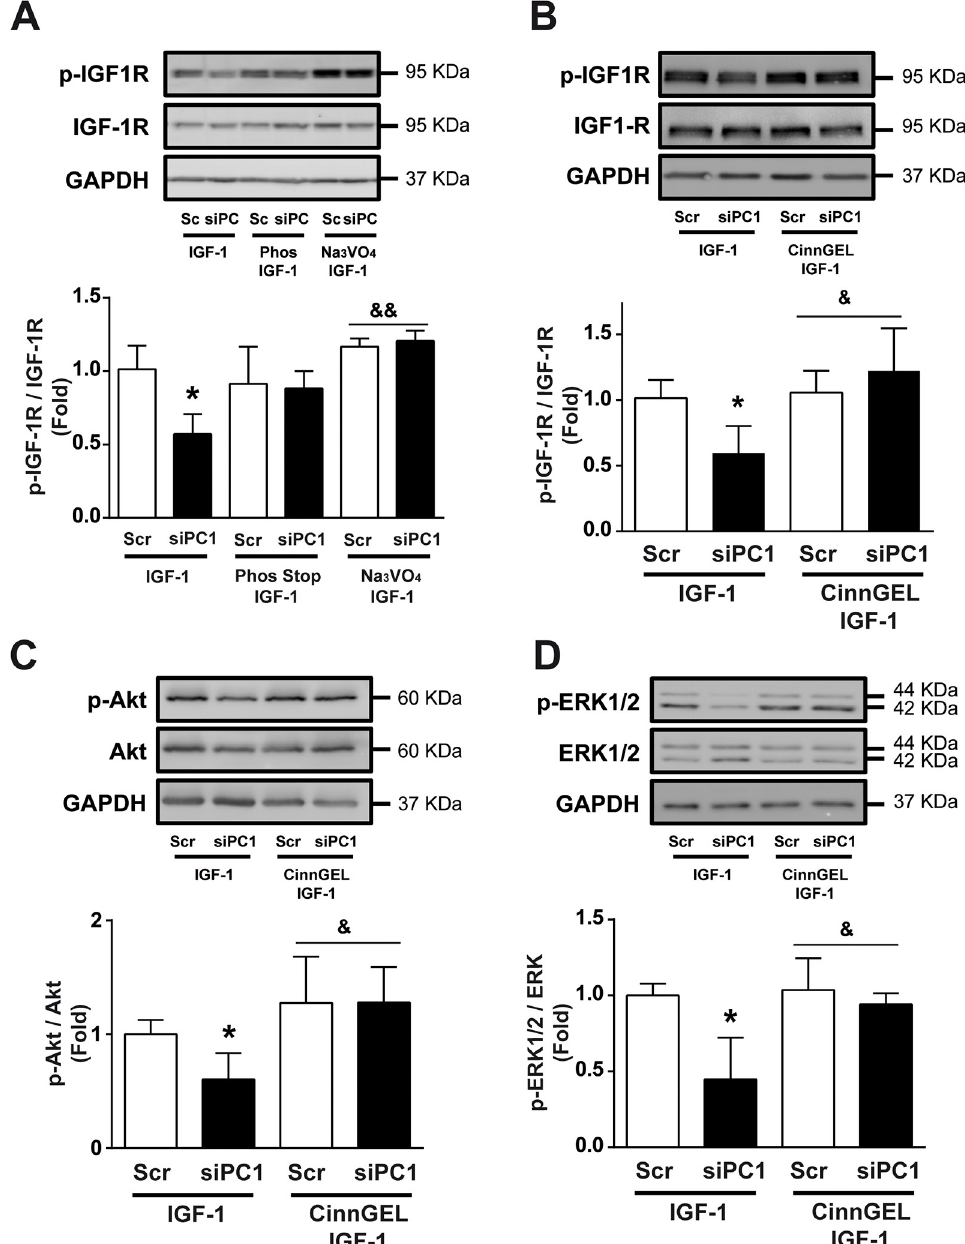
Fig 4. PC1 requires PTP1B to regulate IGF-1-dependent IGF-1R activation. Cardiomyocytes were transfected with scrambled (Scr) or PC1 siRNA (siPC1), incubated for 24 h, and then stimulated with IGF-1 (10 nM) in the presence or absence of the phosphatase inhibitors Phos Stop (1X), Na 3 VO 4 (1 mM) or CinnGEL (10 μ M) for 5 min. Upper panels are representative Western blots of (A and B) phosphorylated IGF-1R (p-IGF1R) and IGF-1R, (C) phosphorylated Akt (p- Akt) and total Akt and (D) phosphorylated ERK1/2 (p-ERK1/2) and total ERK1/2. Lower panels show the (A-B) p-IGF- 1R/IGF1R, (C) p-Akt/Akt, and (D) p-ERK1/2/ERK1/2 ratios. GAPDH was used as a loading control. Values are shown as mean ± SD (n = 3–6). � p < 0.05 vs. Scr+IGF-1, & p < 0.05, && p < 0.01 vs. siPC1+ IGF-1.